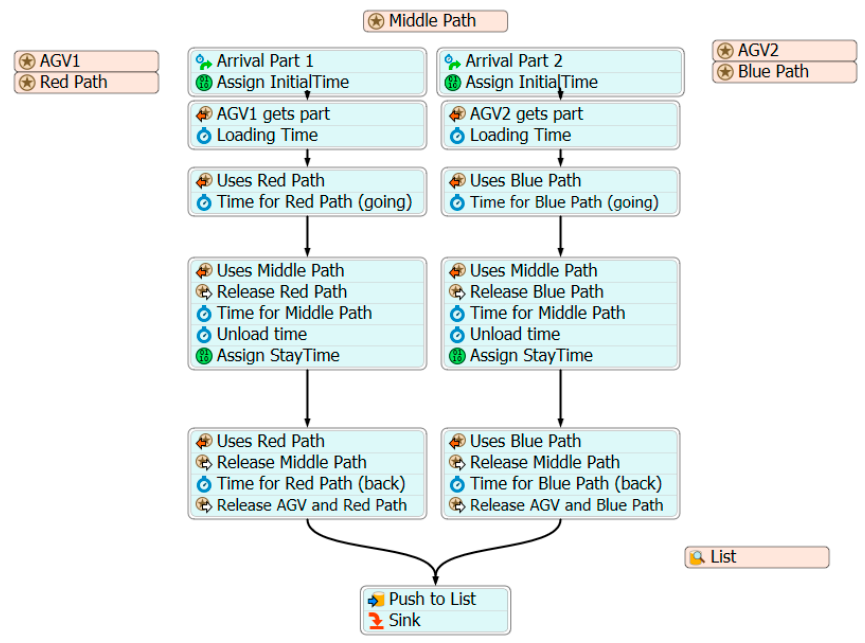
Figure 22. Encoding of both Petri nets in FlexSim. Proposed solution (blocking the middle path).